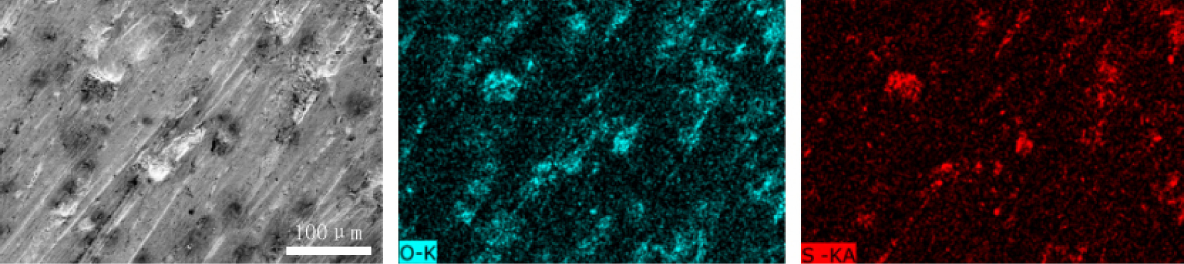
Figure 14. The element distribution of worn surface of ZM4-13 under coal gangue percentage of 50% and pH values of simulated mine water of